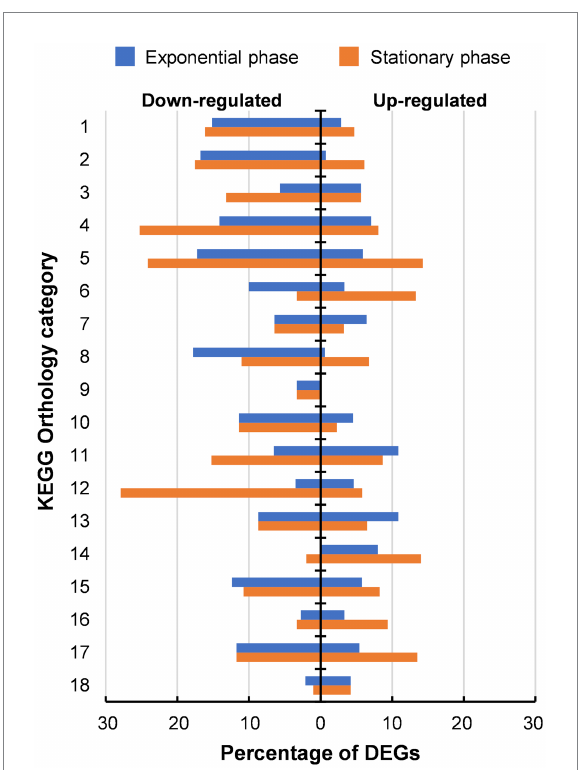
FIGURE 4 Distribution of differentially expressed genes (DEGs) identified in 46 T-a in comparison with AWRP. DEGs are categorized based on KEGG pathway annotations. The numbered categories are: 1, carbohydrate metabolism (211); 2, energy metabolism (131); 3, lipid metabolism (53); 4, nucleotide metabolism (99); 5, amino acid metabolism (203); 6, metabolism of other amino acids (30); 7, glycan biosynthesis and metabolism (31); 8, metabolism of cofactors and vitamins (163); 9, metabolism of terpenoids and polyketides (30); 10, biosynthesis of other secondary metabolites (44); 11, xenobiotics biodegradation and metabolism (46); 12, translation (86); 13, folding, sorting and degradation (46); 14, replication and repair (50); 15, membrane transport (121); 16, signal transduction (181); 17, cellular community (111); and 18, cell motility (95). The number in parentheses after each category is the total number of annotated genes in the AWRP